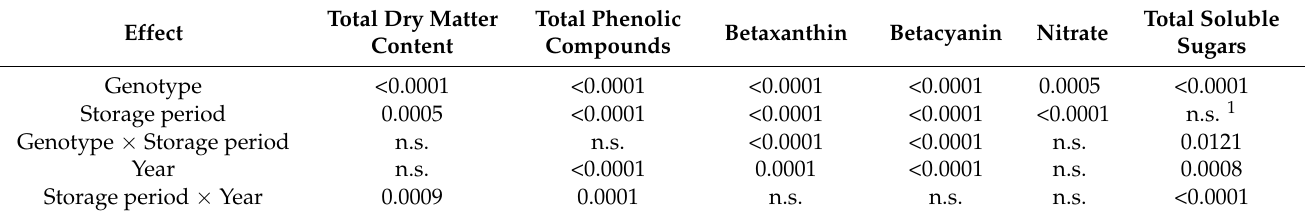
Table 2. ANOVA of results of total dry matter, total phenolic compounds, betaxanthin, betacyanin, nitrate, and total soluble sugars of 36 beetroot genotypes grown in research station Kleinhohenheim within the years 2017 and 2018 for three storage periods (storage period expressed as cold storage durations of zero (directly after harvest), one, and four